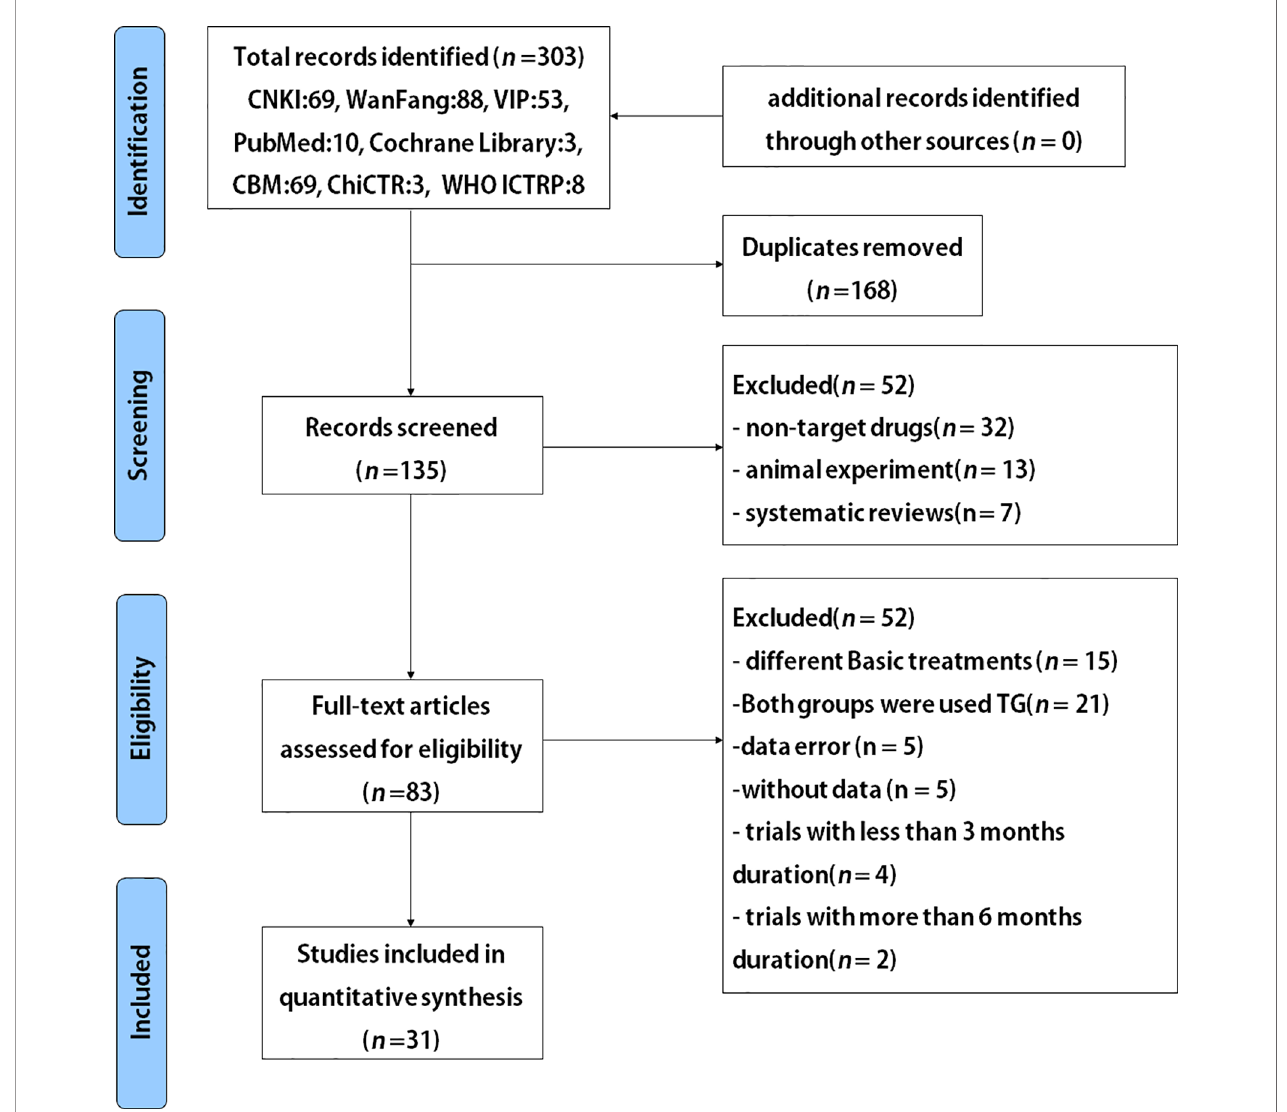
FIGURE 1 | Flowchart for randomized controlled trials (RCTs) to evaluate the use of TG after 3 and 6 months of treatment durations in patients with